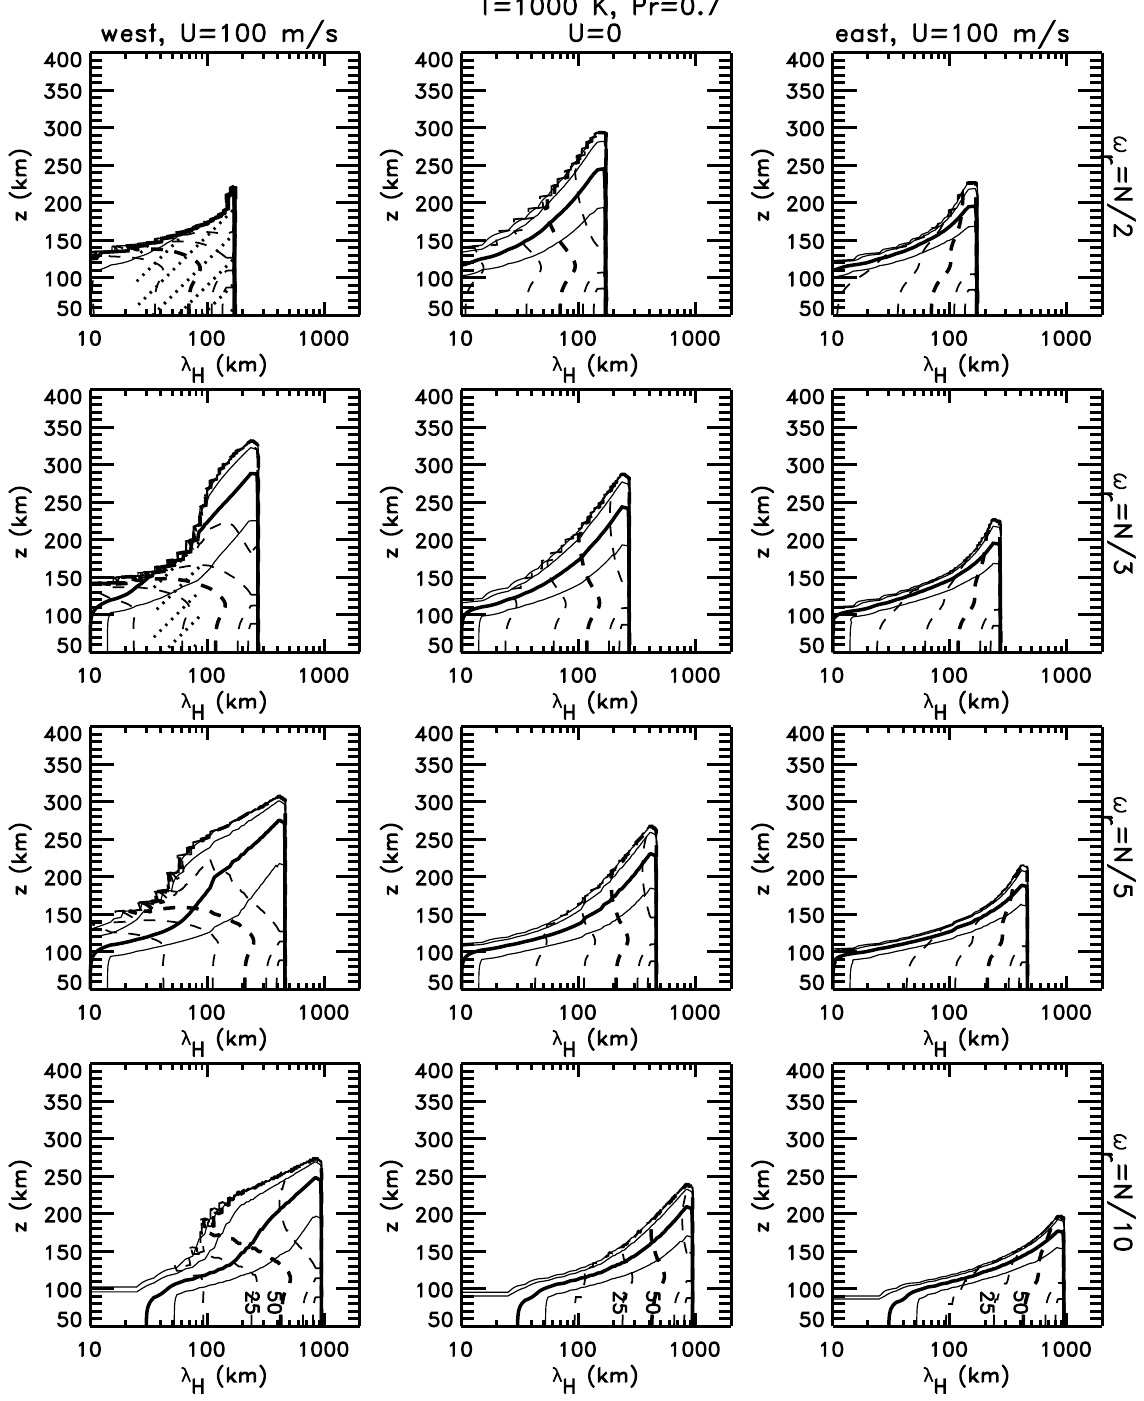
Fig. 3. As in Fig. 2, but for mean solar forcing and thermospheric temperatures ( ∼ 1000K).